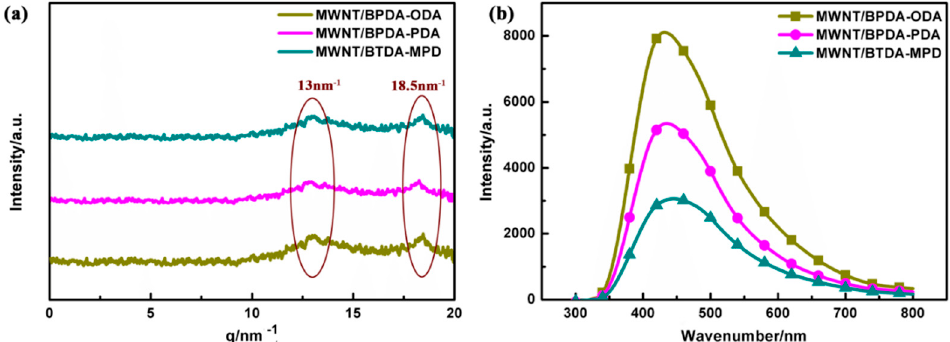
Figure 8. ( a ) SEM image of MWNT / PI composites. HRTEM image of ( b ) aligned MWCNT and ( c ) MWNT / PI composites.